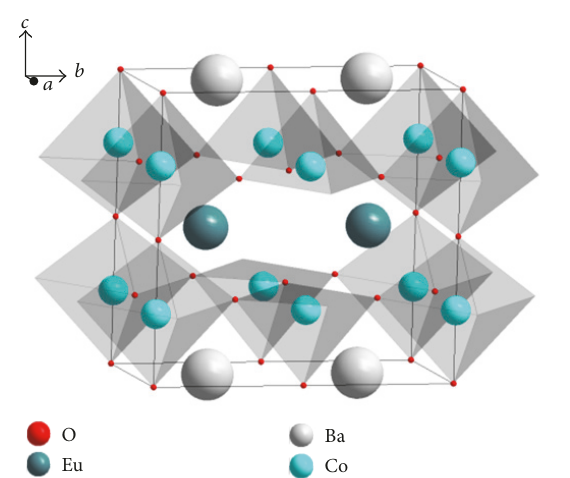
Figure 1: Unit cell of EuBaCo 2 O 5.5 with orthorhombic symmetry, s.g. Pmmm.